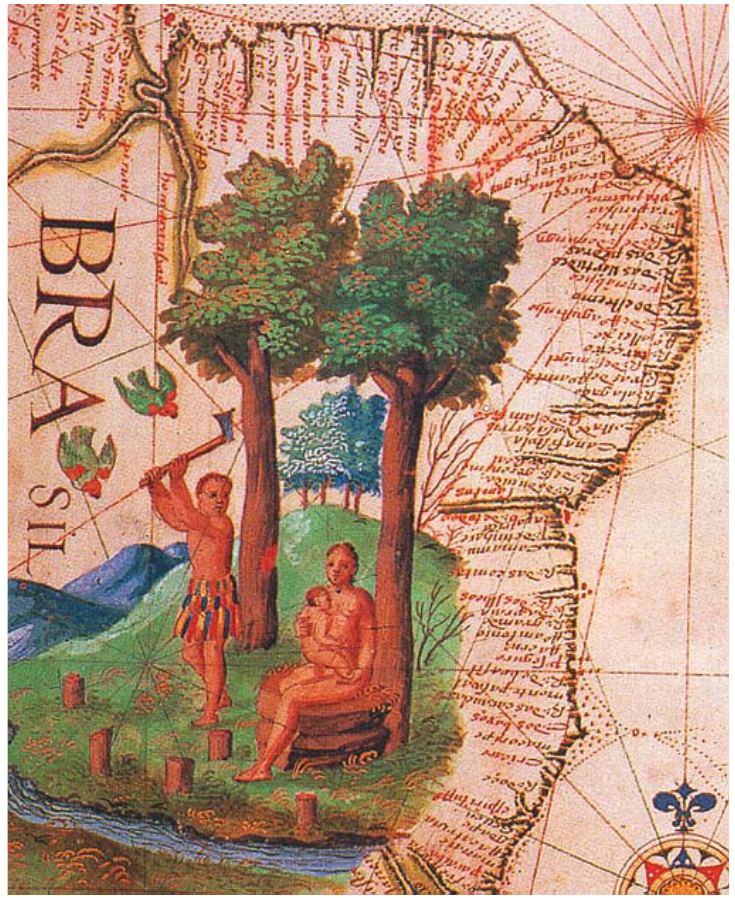
Fig. 7 – Detail of Carta do Brasil of the Atlas of Sebastião Lopes, 1565 (Domingues